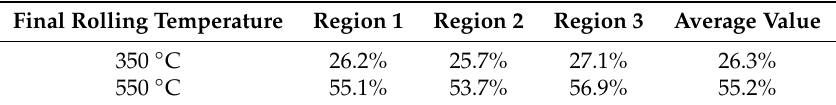
Figure 6. EBSD maps of the ECAR-CB AZ31 Mg alloy sample at final rolling temperature of 550 °C: ( a ) inverse pole figure (IPF) map and ( b ) grain boundaries (GB) map. Table 1. Calculated area fractions of {10–12} extension twins for the ECAR-CB samples prepared at 350 and 550 °C.